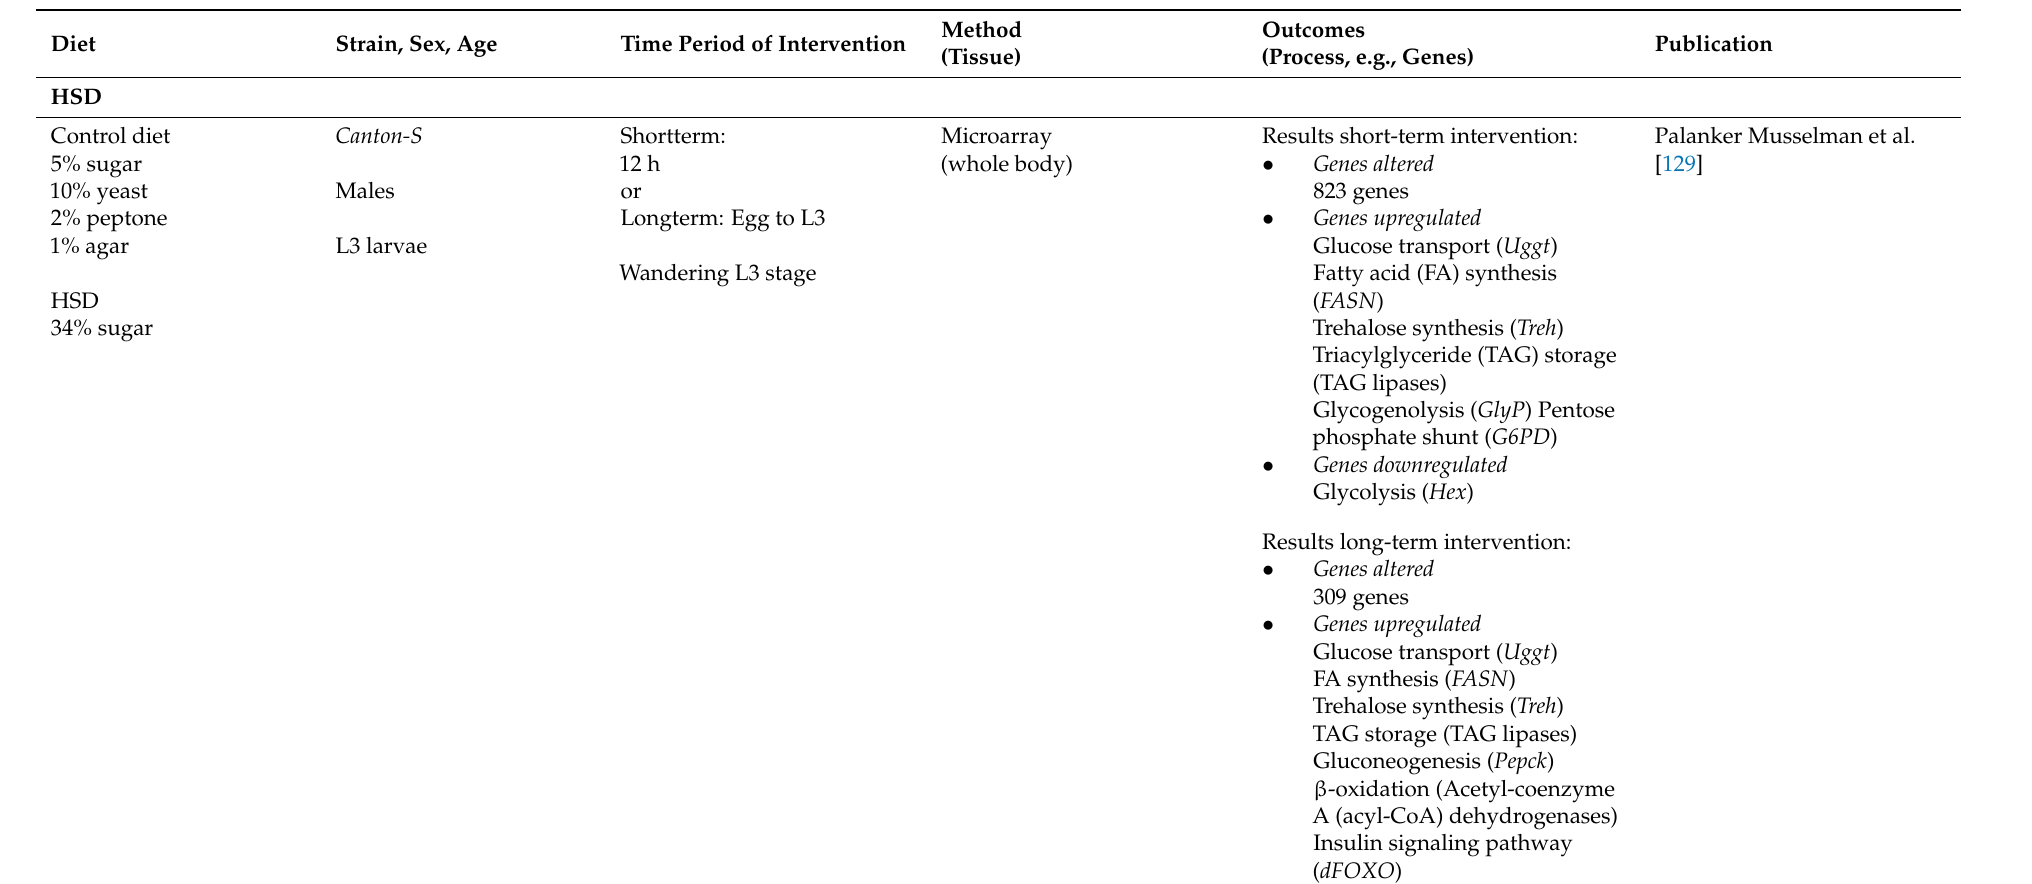
Table 4. Overview of dietary intervention studies regarding changes in transcriptome following high-sugar diet (HSD) or high-fat diet (HFD) feeding in Drosophila melanogaster . The studies are ordered by release